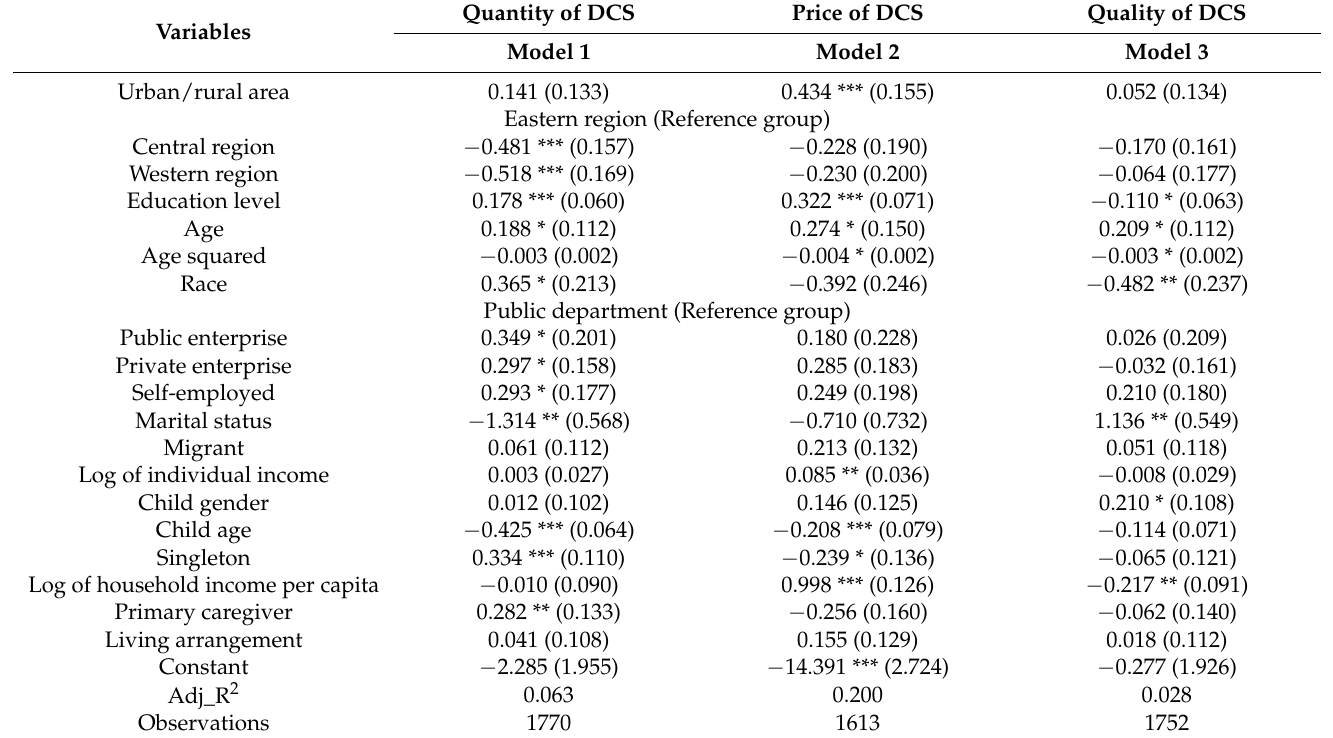
Table 2. The results of benchmark